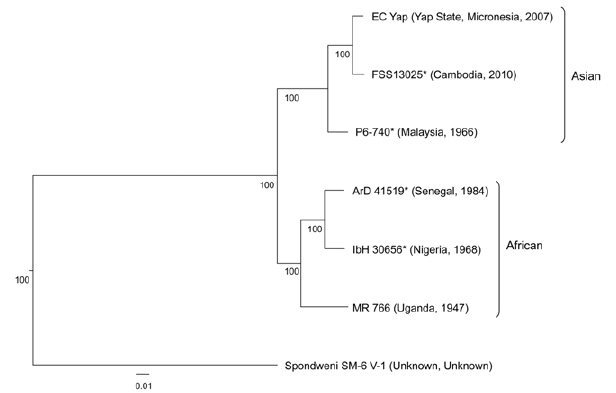
Figure 1. Zika virus nucleotide and amino acid alignments. Neighbor-joining phylogeny generated from open reading frame nucleotide sequences of Zika virus strains. The tree was rooted with Spondweni virus (GenBank accession number DQ859064). The scale at the bottom of the tree represents genetic distance in nucleotide substitutions per site. Numbers at the nodes represent percent bootstrap support values based on 1,000 replicates. Isolates are represented according to strain name, country of origin, and year of isolation. The lineage of each virus is indicated to the right of the tree. *Strains sequenced in this study.